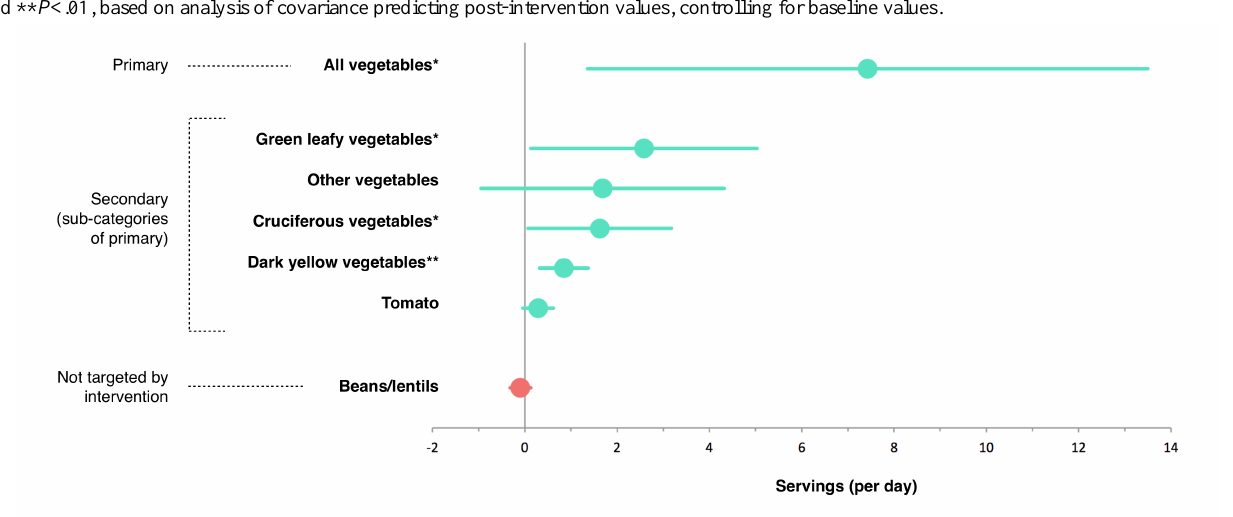
Figure 4. Differences in vegetable consumption, 12 weeks after randomization (n=17). Adjusted mean difference (circles) and 95% confidence intervals (horizontal lines) between intervention condition (mobile app) and control condition (no mobile app): all vegetables 7.4 (1.4-13.5); green leafy vegetable 2.6 (0.1-5.0); other vegetables 1.7 (−0.9 to 4.3); cruciferous vegetables 1.6 (0.7-3.2); dark yellow vegetables 0.8 (0.3-1.4); tomato 0.3 (−0.04 to 0.6); and beans/lentils −0.1 (−0.3 to 0.1). An intention-to-treat analysis was used, with baseline values carried forward when participants were lost to follow-up.